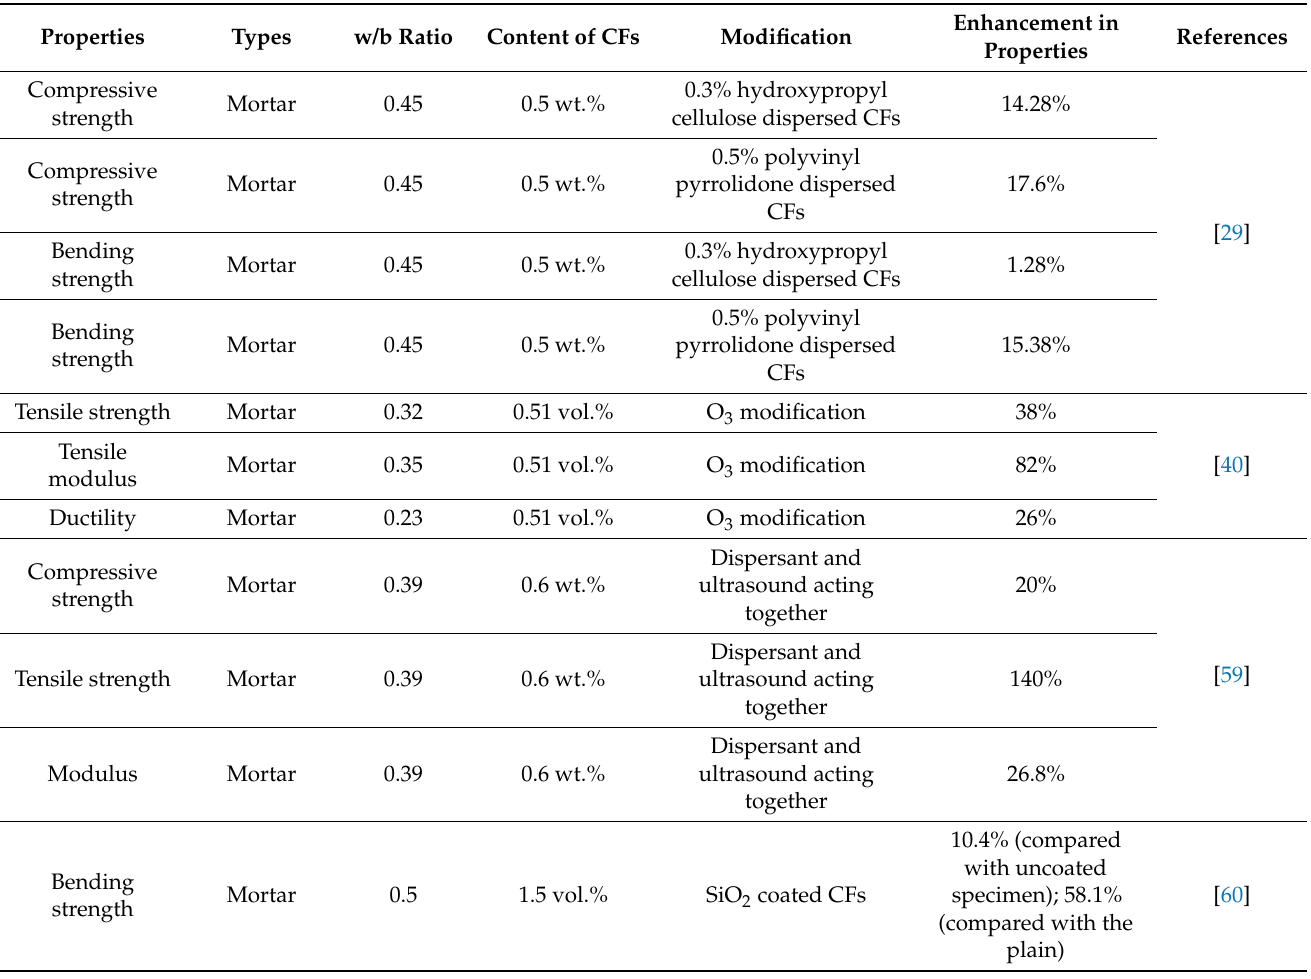
Table 3. Mechanical and durability properties of chemically modified